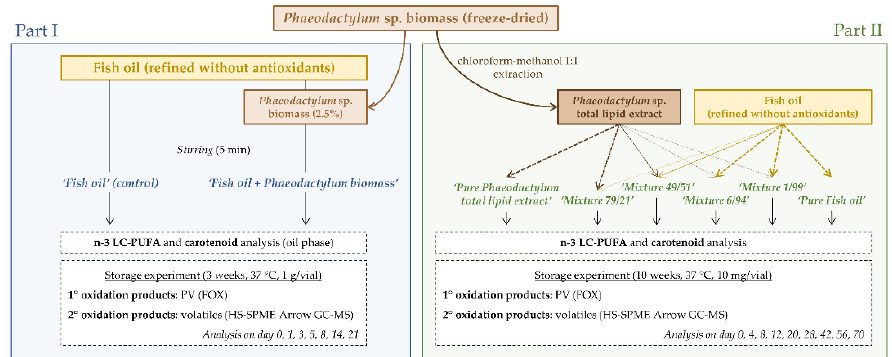
Figure 1. Experimental